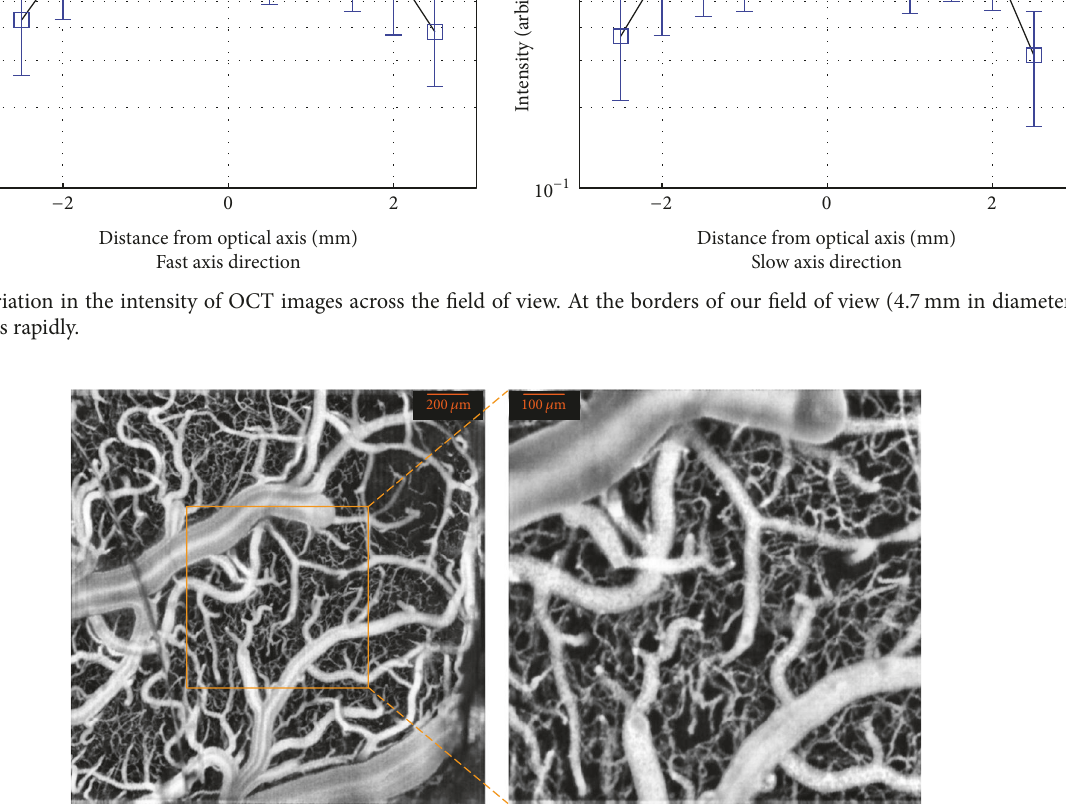
declines noticeably. A combination of beam truncation